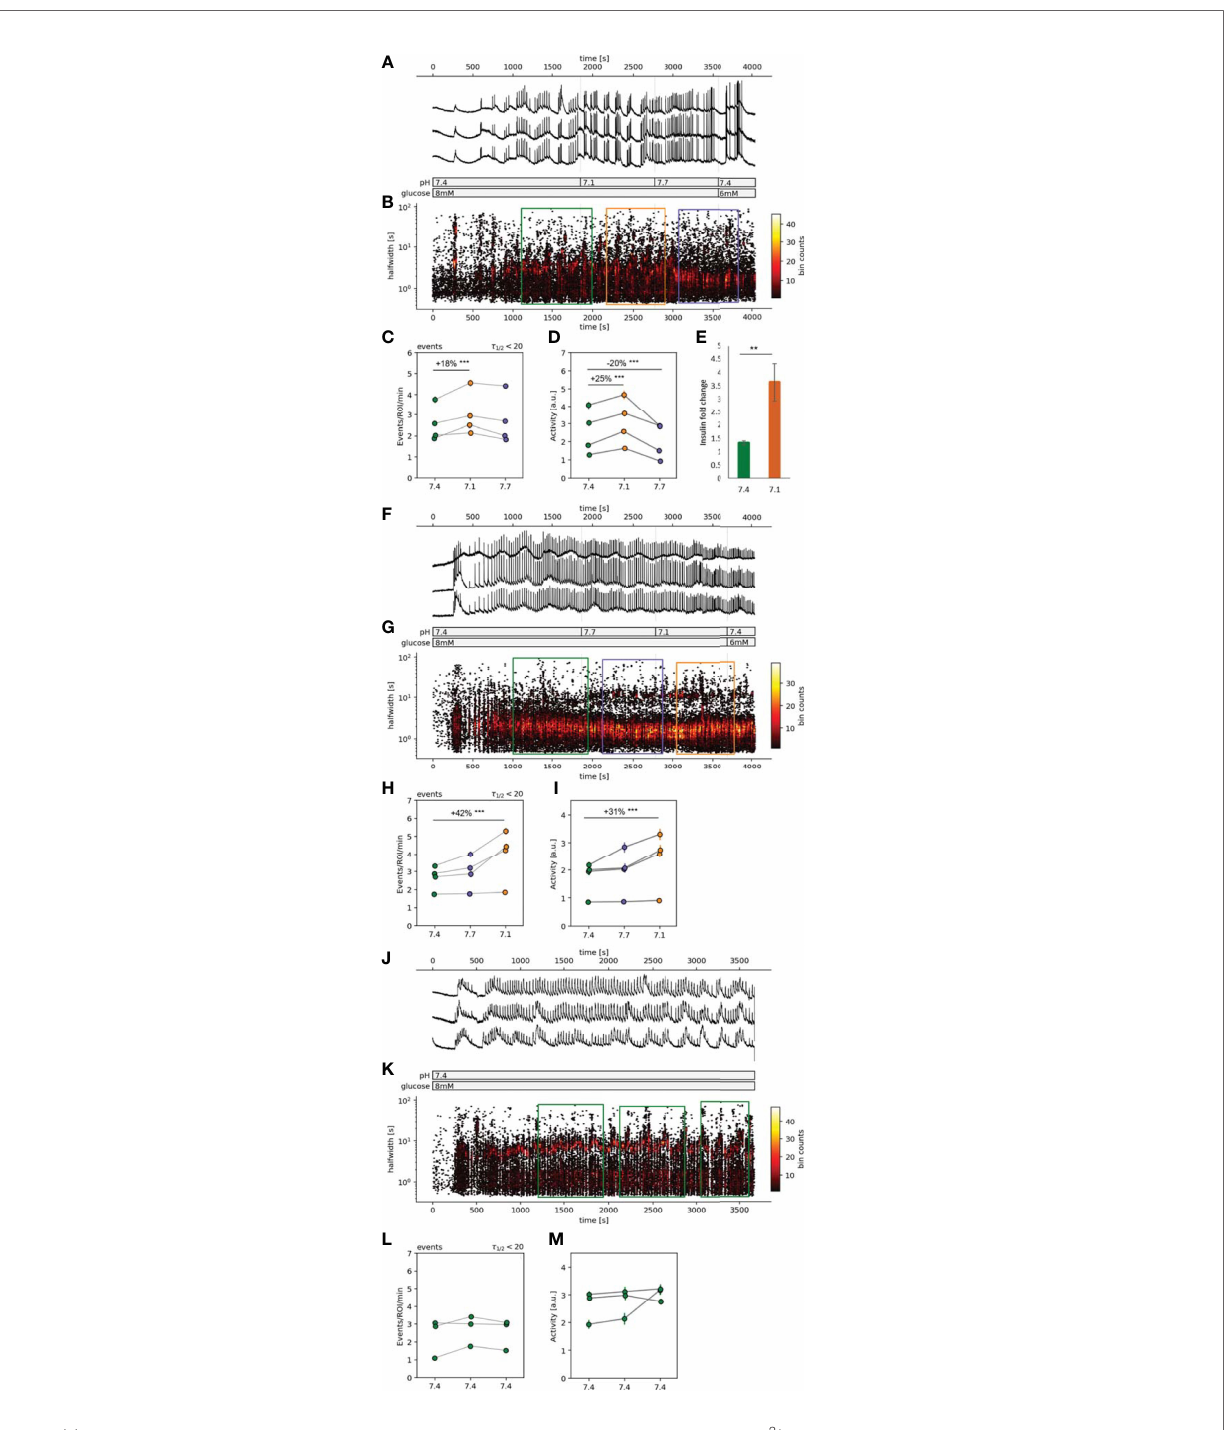
FIGURE 2 | | Spatiotemporal characterization of beta cell plateau activity. (A, F, J) Time course of the [Ca 2+ ] c oscillations, exposed to 8 mM glucose stimulation protocol with pH manipulations during the stable plateau phase. (B, G, K) Hexbin plot of all detected [Ca 2+ ] c oscillations presented as the time of the peak vs. the halfwidth of [Ca 2+ ] c oscillation duration. The sections in the color-coded rectangles were used for the further statistical analysis (orange=pH 7.1, green=pH 7.4 and purple=pH 7.7). (C, H, L) Quanti fi cation of frequency of the [Ca 2+ ] c oscillations expressed as number of events per minute per ROI. (D, I, M) Quanti fi cation of the [Ca 2+ ] c oscillations halfwidths. (E) In vitro insulin secretion from 50 isolated islets monitored over 75 min. Data is normalized to the basal insulin secretion at 6 mM glucose (5 min incubation), and presented as mean, the error bars represent standard deviation of the mean. Experiments from the individual islets are connected with a line. (**p < 0.01, ***p <